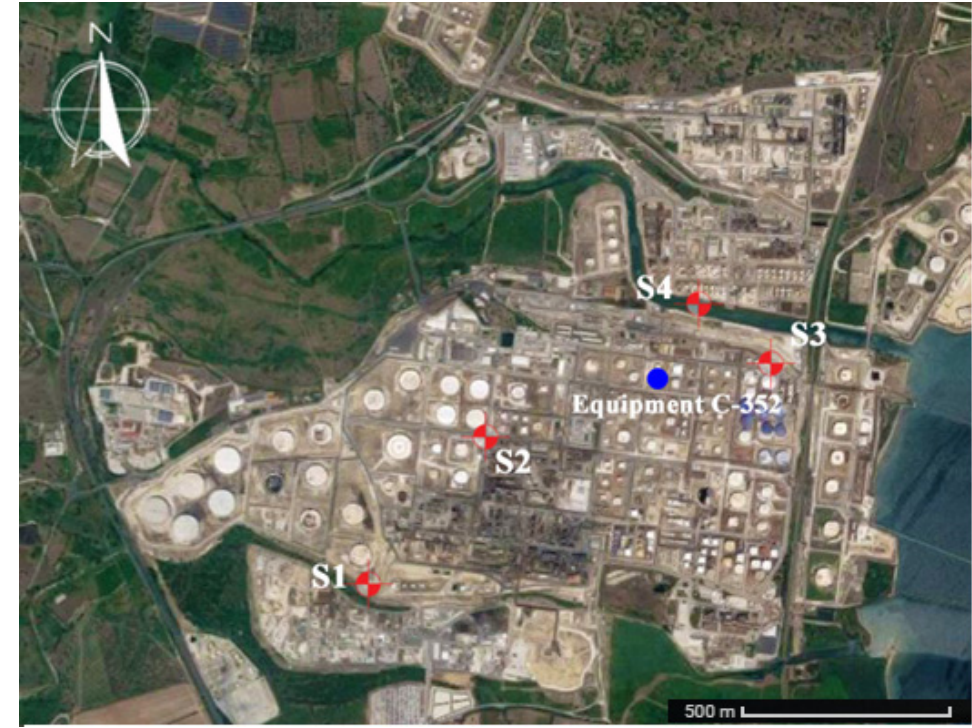
Figure 5. Location of boreholes (S1 – S4) in the studied area (After Google Maps, modified). The results of the boreholes are as follows.